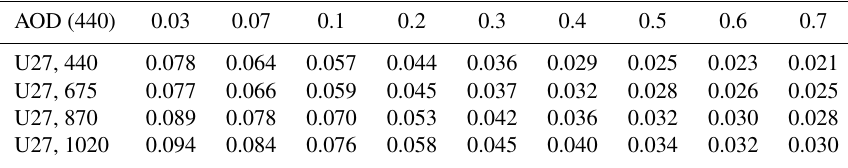
Table 16. Average SSA uncertainties estimated at Mongu.